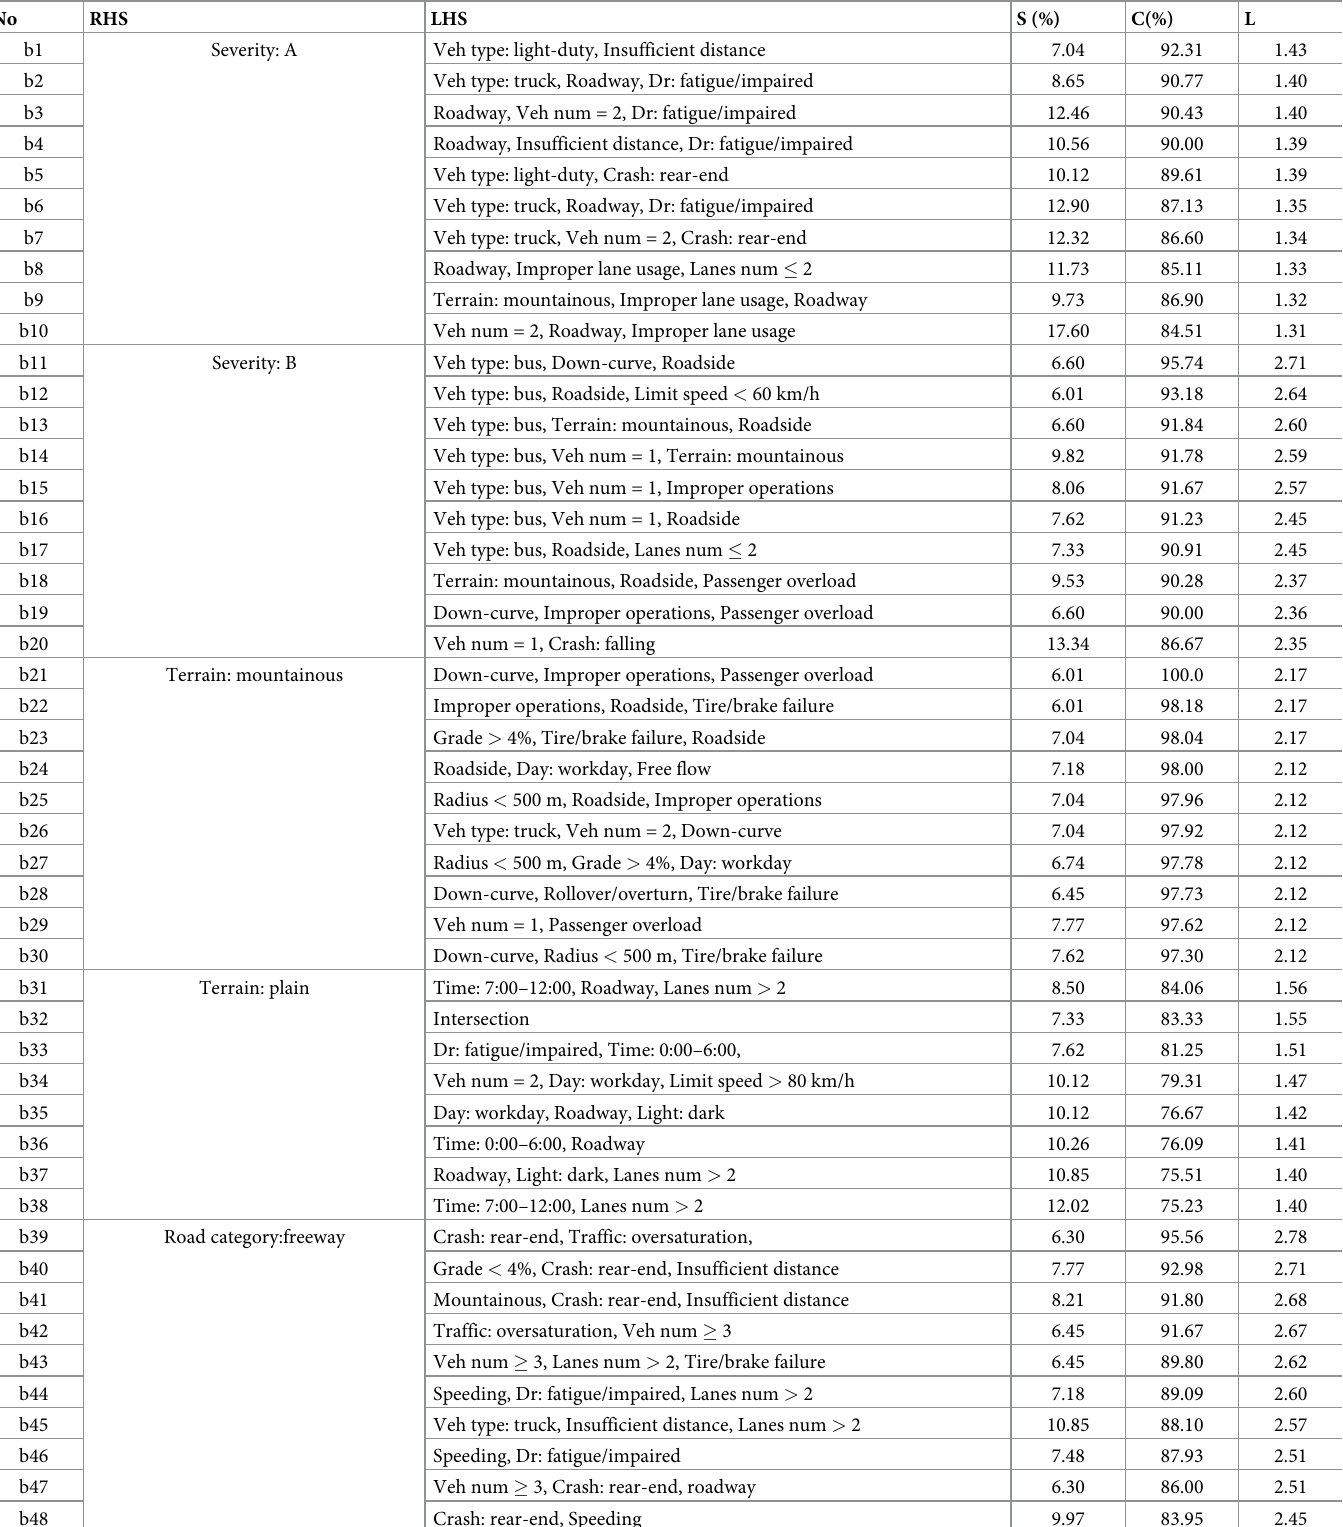
Table 4. Rules involving high-frequency RHS